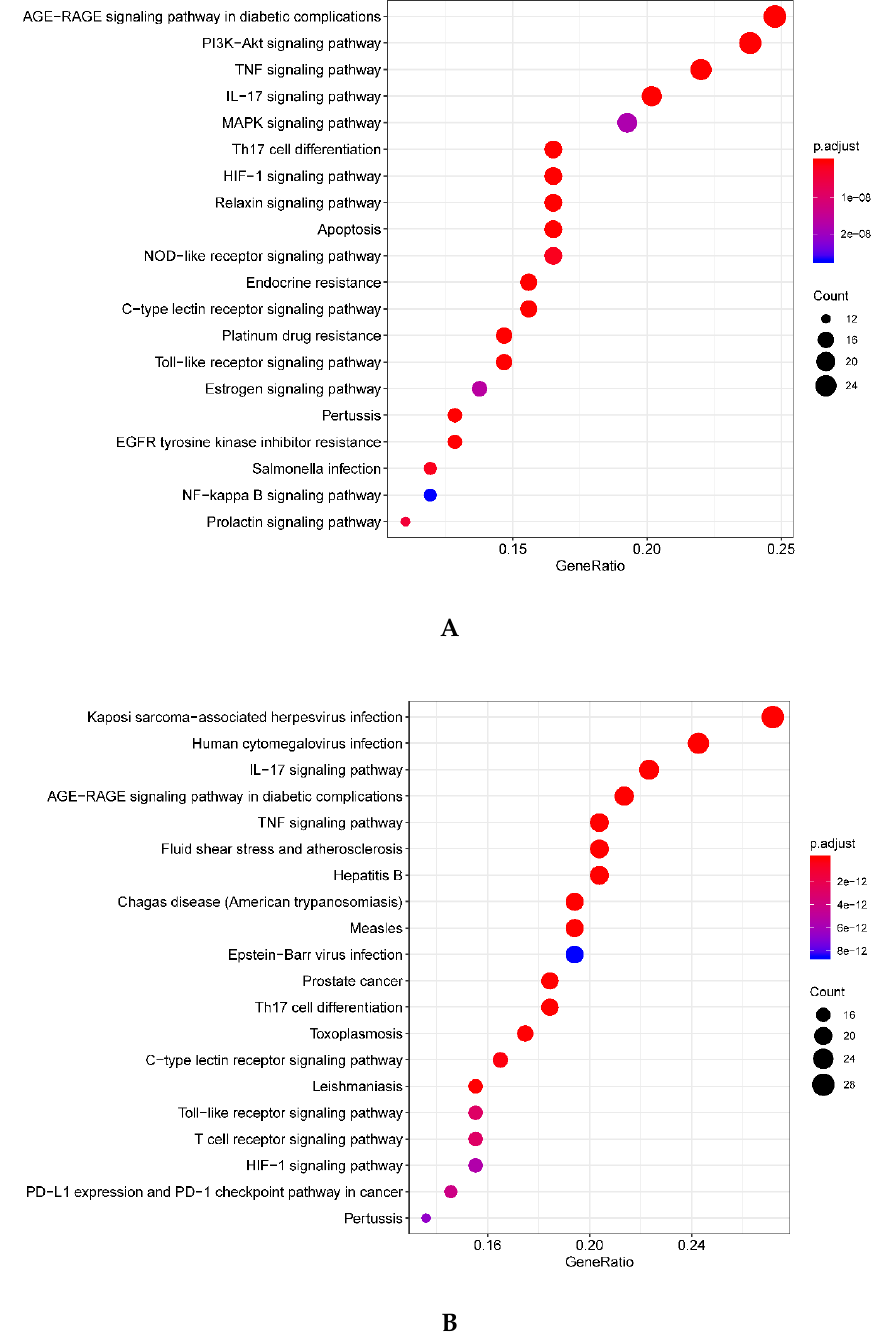
Figure 5. The top 20 significant enriched KEGG pathways for intersection targets between ( A ) compound (OB ≥ 30% and DL ≥ 0.18) and AD-related targets, and ( B ) compound (OB < 30% and DL ≥ 0.18) and AD-related targets. AD: atopic dermatitis. OB: oral bioavailability; DL: drug-likeness.